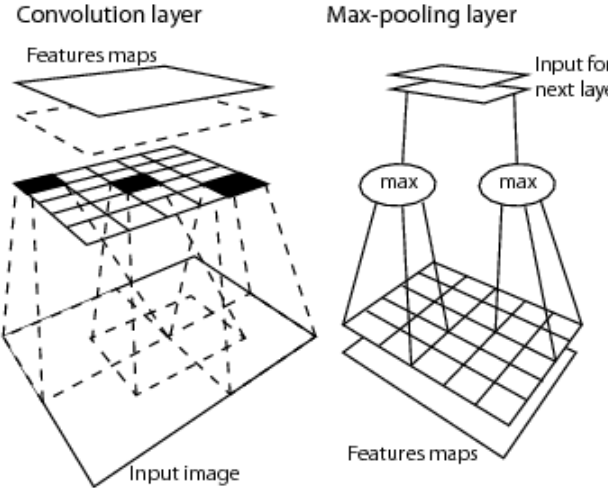
Figure 16. 2D image analysis is synonym for spatial context-sensitive and spatial topology-preserving (retinotopic) feature mapping in a (2D) image-domain [13,87,88,96,170]. Intuitively, 2D image analysis is sensitive to permutations in the input data set [34]. Activation domains of physically adjacent processing units in the 2D array of convolutional spatial filters are spatially adjacent regions in the 2D visual field. Provided with a superior degree of biological plausibility in modelling 2D spatial topological and spatial non-topological information components, distributed processing systems capable of 2D image analysis, such as deep convolutional neural networks (DCNNs), typically outperform traditional 1D image analysis approaches. Will computers ever become as good as humans in 2D image analysis?